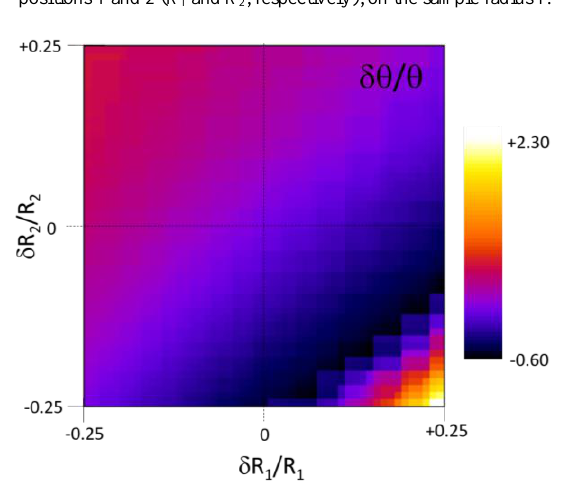
Fig. 9. Angle parameter  sensitivity to the gamma-ray ratio variations.